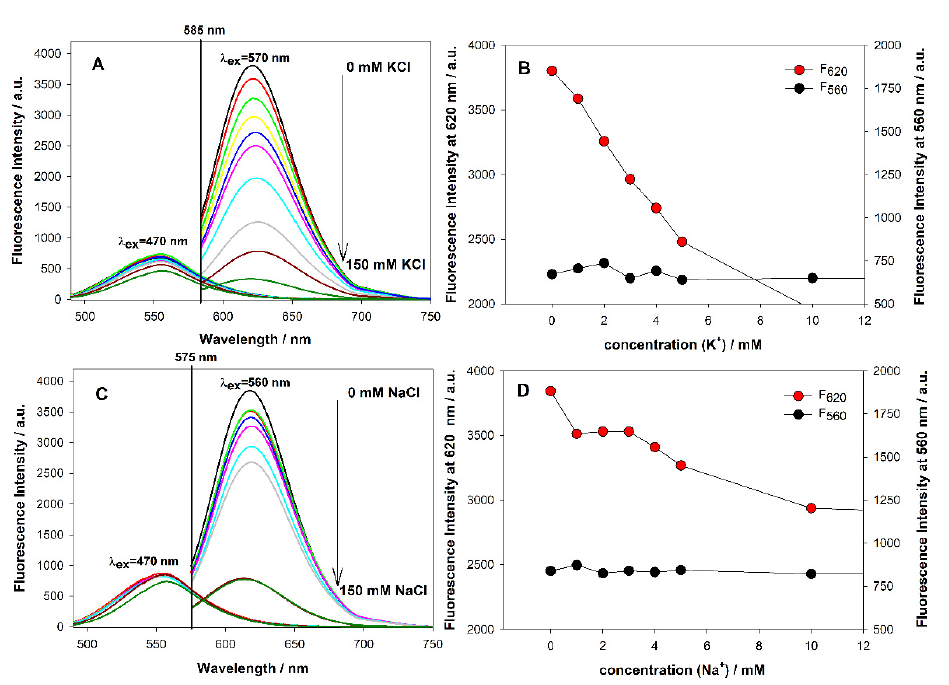
Figure 6. Effect of cations on fluorescence properties of Tel22C12-AgNCs: ( A ) emission spectra in presence of increasing K + concentration; ( B ) changes in maximum intensity of green and red fluorescence upon K + addition; ( C ) emission spectra in presence of increasing Na + concentration; ( D ) changes in maximum intensity of green and red fluorescence upon Na + addition.